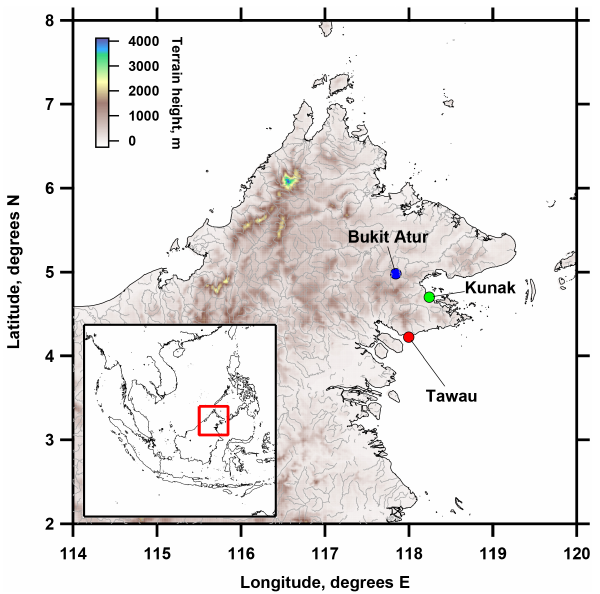
Figure 1. Site location map for Sabah. The inland rainforest site on Bukit Atur is shown by the blue circle, the coastal site near Tawau is a red circle and the coastal site at Kunak (green circle) is also shown as featured in Pyle et al. (2011b). The Tawau site is ∼ 85km to the south of Bukit Atur. The inset (lower left corner of main panel) shows the southeast Asia region with a red square to show coverage of the main